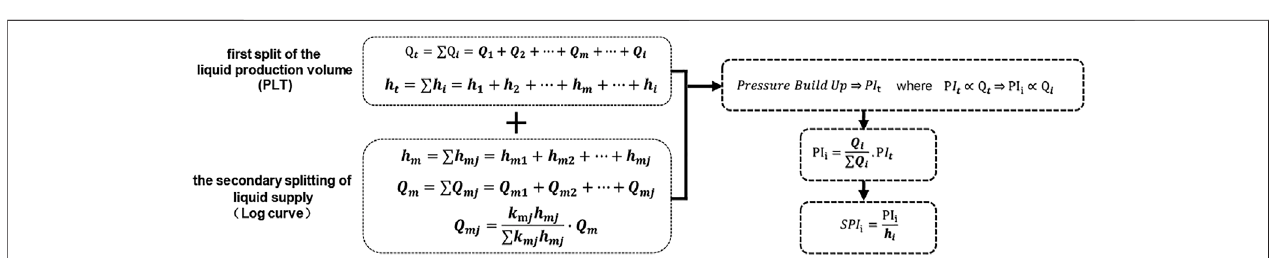
FIGURE 7 | The work fl ow of the calculation method of speci fi c production liquid index.